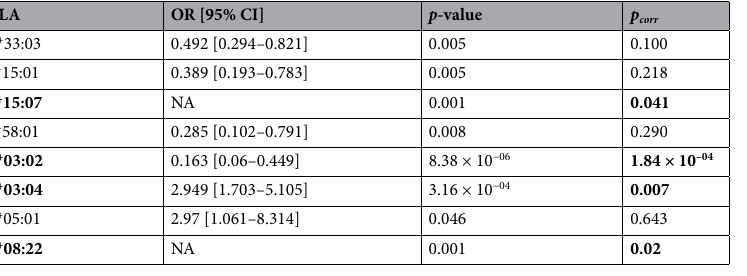
Table 2. HLA class I alleles associated with sarcoidosis in Korean patients (only the alleles associated at least on a primary level are shown). NA not analyzed (no variants were present in one of the analyzed groups), OR odds ratio, CI confidence interval, HLA human leukocyte antigen. Significant p corr ( p -value after correction for multiple comparisons) in bold.